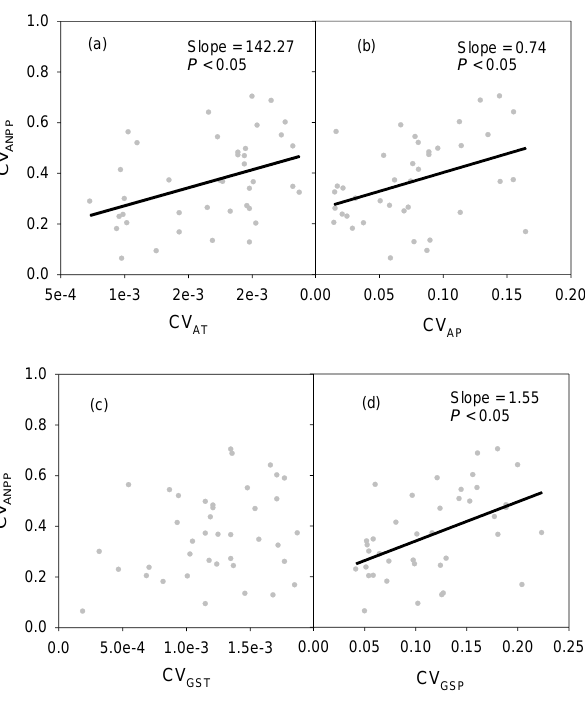
Fig. 5. Linear relationships for CV of aboveground net primary pro- duction (ANPP) with CV of annual temperature (a) , CV of annual precipitation (b) , CV of growing season temperature (c) , and CV of growing season precipitation (d) from 2006 to 2009. Significant regression lines at P < 0 . 05 are shown.